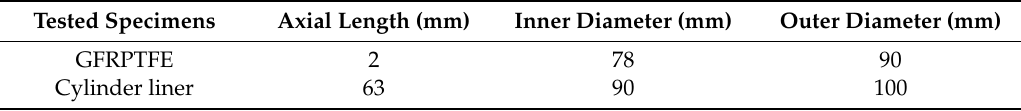
Figure 1. The schematic of the interrupted wear test configurations. ( a ) The friction pairs and ( b ) the arrangement of the test rig. Table 2. The dimensions of the GFRPTFE specimens and steel cylinder liner specimens.